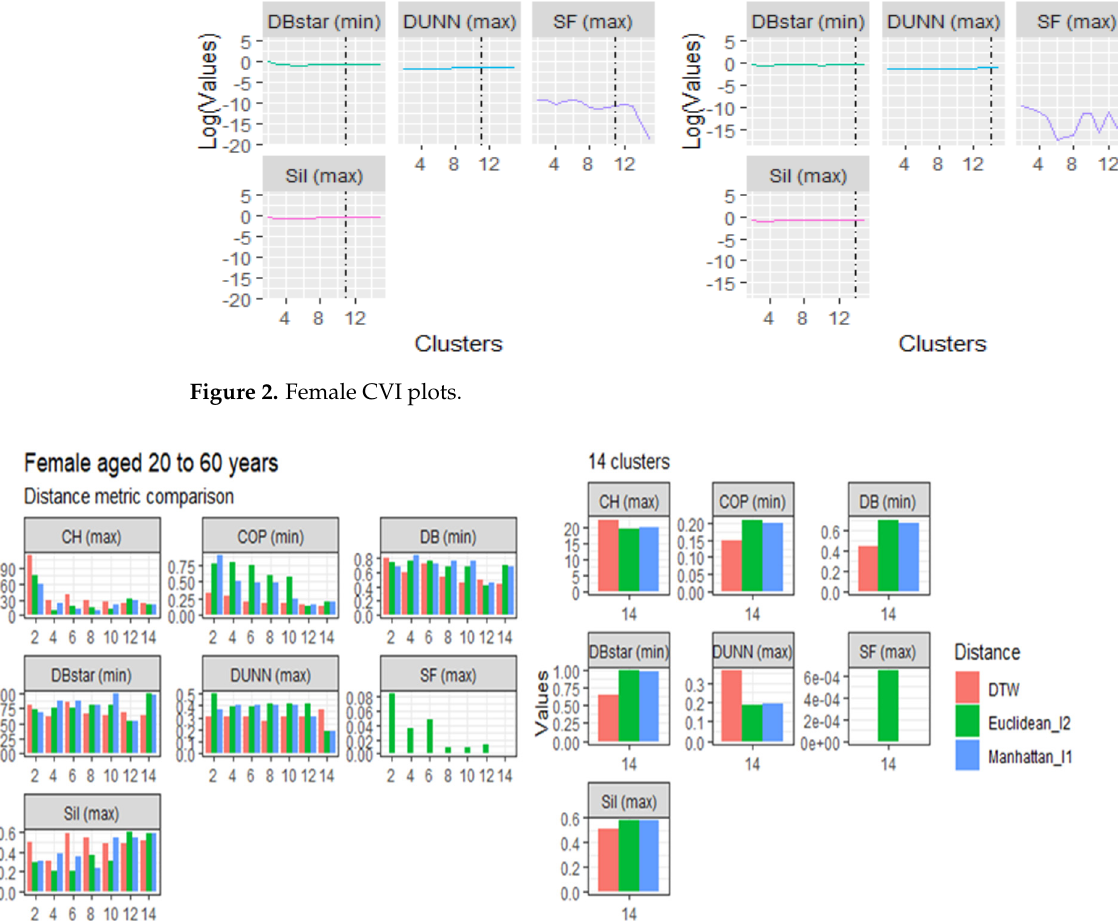
Figure 4. Model comparison of the DTW, Euclidean (l1), and Manhattan (l2) distance criteria for fe- males aged over 60. Figure 5. Model comparison of the DTW, Euclidean (l1), and Manhattan (l2) distance criteria for males aged 20 to 60.